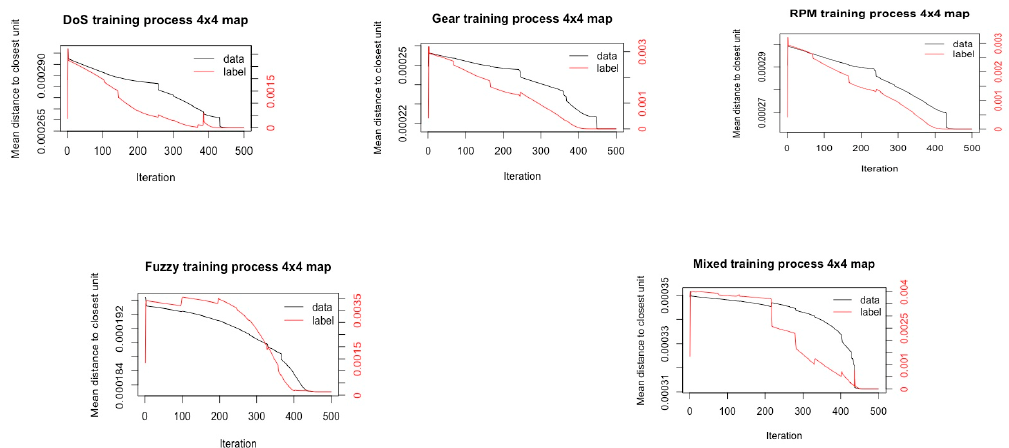
Figure 12. XYF Kohonen network training process for the 4 × 4 maps.